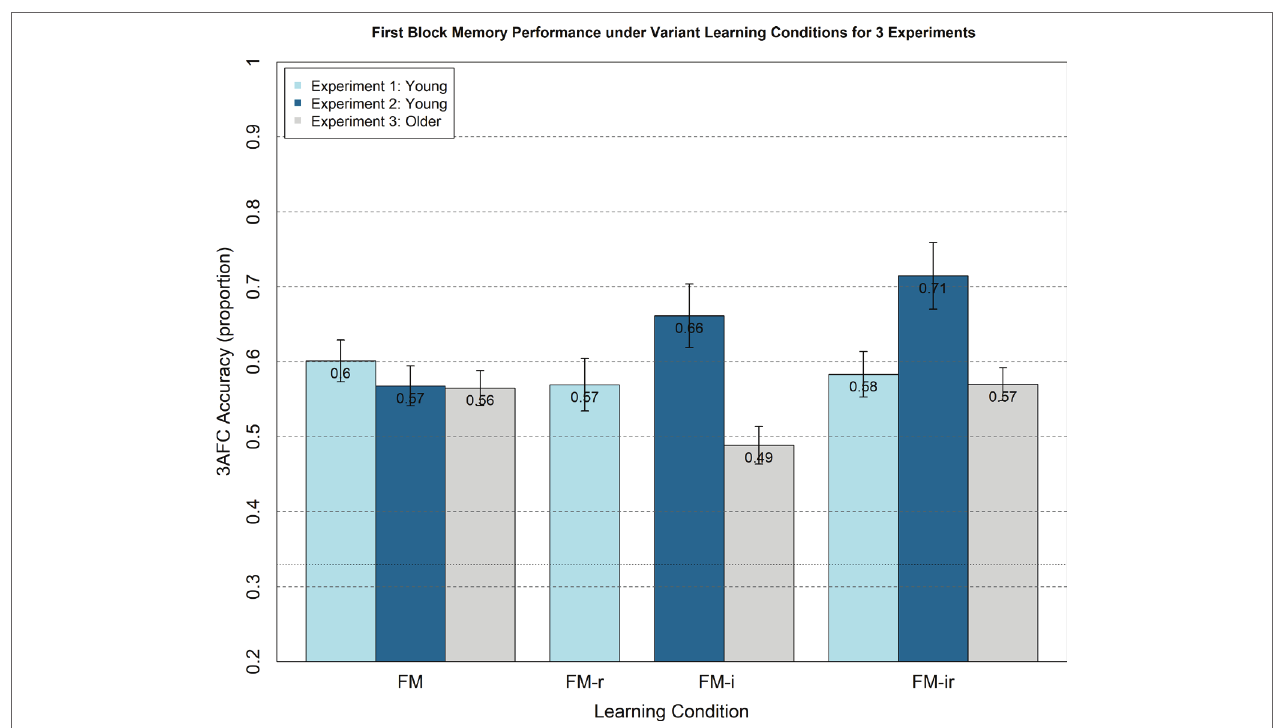
FIGURE 3 | Analogous plot to Figure 2 , except 3AFC memory test performance (chance = 0.33) is from the first study-test block only, for which participants were not aware of test